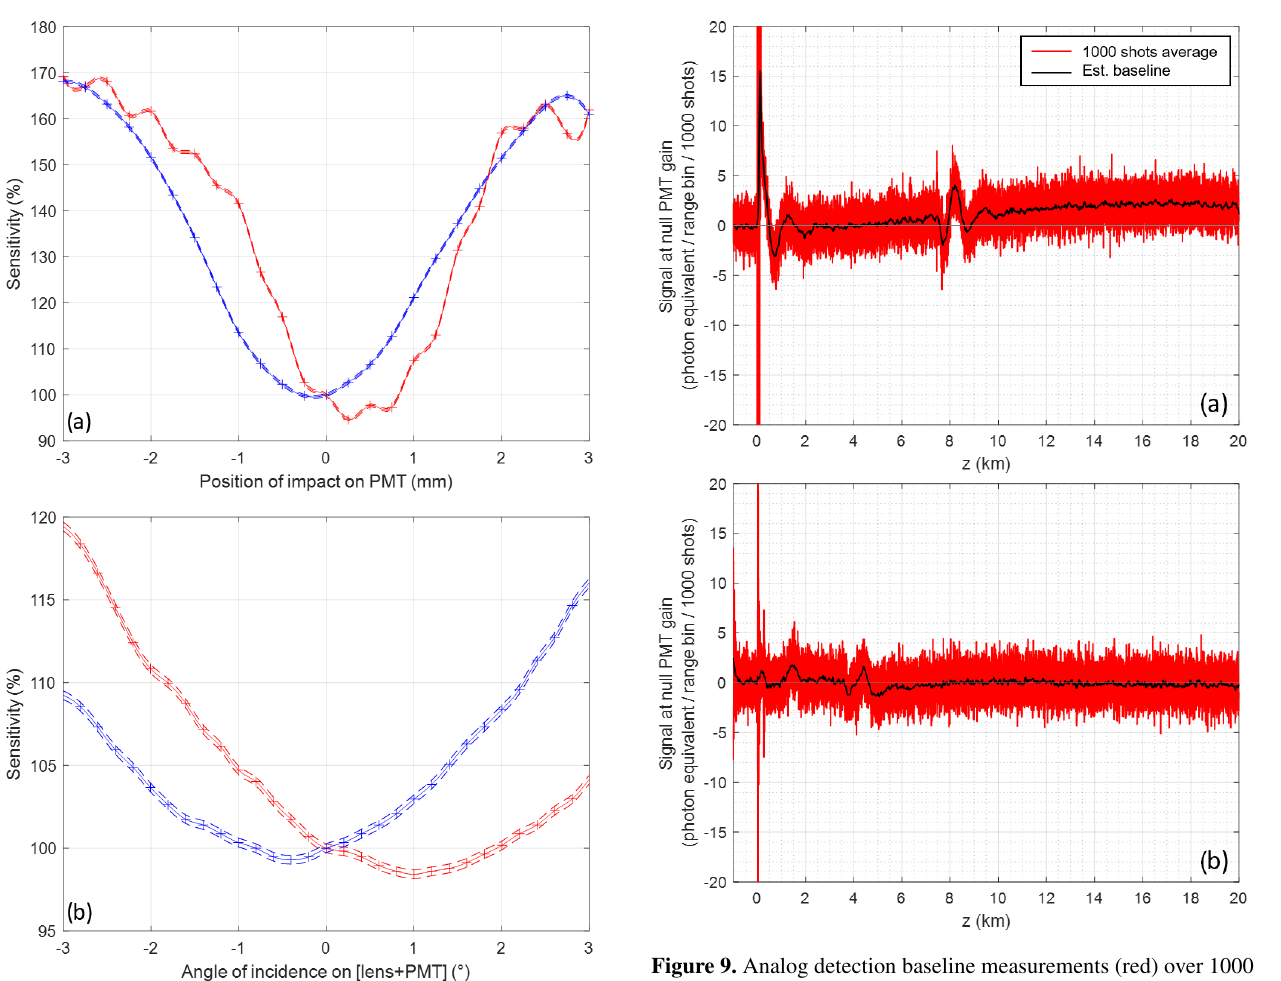
Figure 9. Analog detection baseline measurements (red) over 1000 laser shots with PMT gains set to zero, expressed in photon counts equivalent on the RR2 channel: (a) in an unfavorable case (no mit- igation), showing both baseline fluctuations over time (20km ∼ 133µs) and strong electro-magnetic parasites at large distance, and (b) on the WALI system, after mitigation. The final estimated base- line ( ˆ L j (z) in Eq. 3) obtained after smoothing, which is subtracted to all recorded profiles, is in